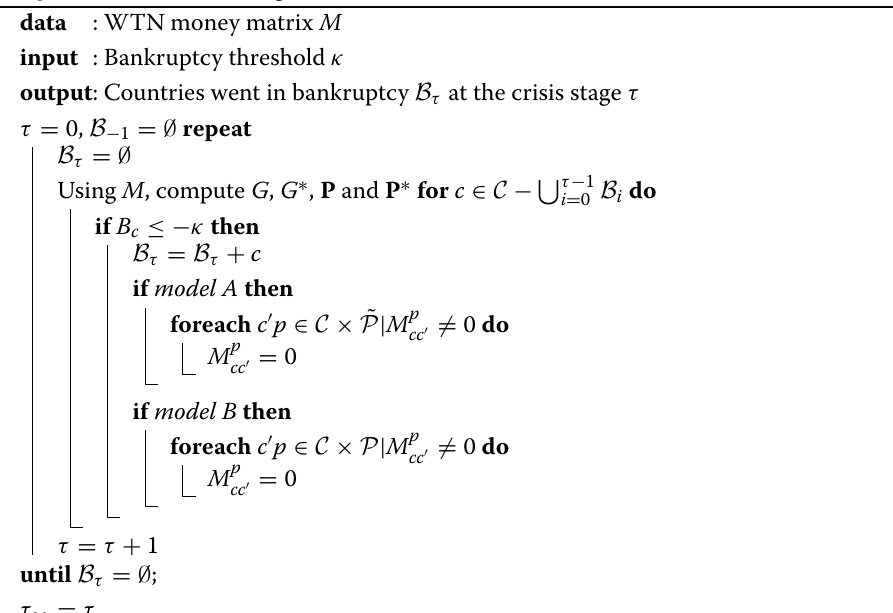
Algorithm 1: Crisis contagion in the WTN.